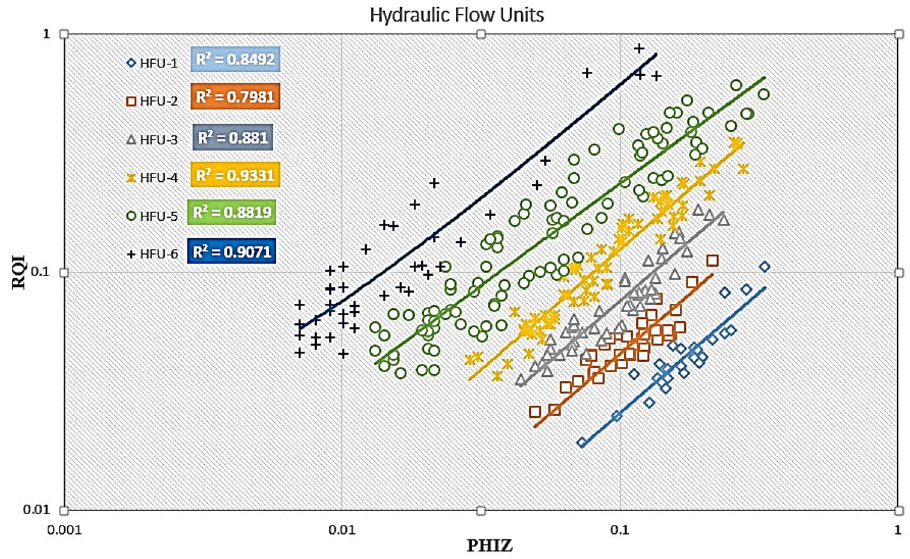
Fig. 14 The plot of reservoir quality index (RQI) vs. normal- ized porosity (PHIZ)